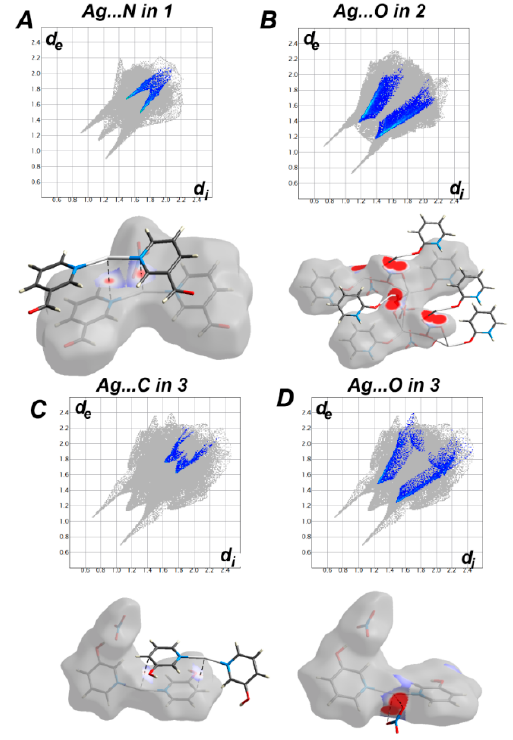
Figure 10. The rest of the most important contacts in complexes 1 – 3 .